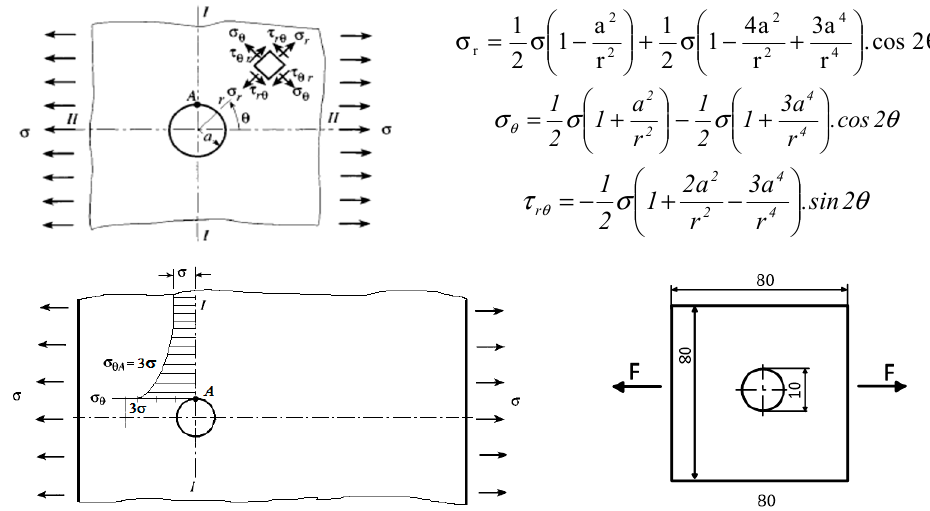
Figure 1. Analytical solution and stress diagram for circular hole in the center of a wide sheet loaded in tension (K σ = 2.625, σ max = 375 MPa [10,11]).